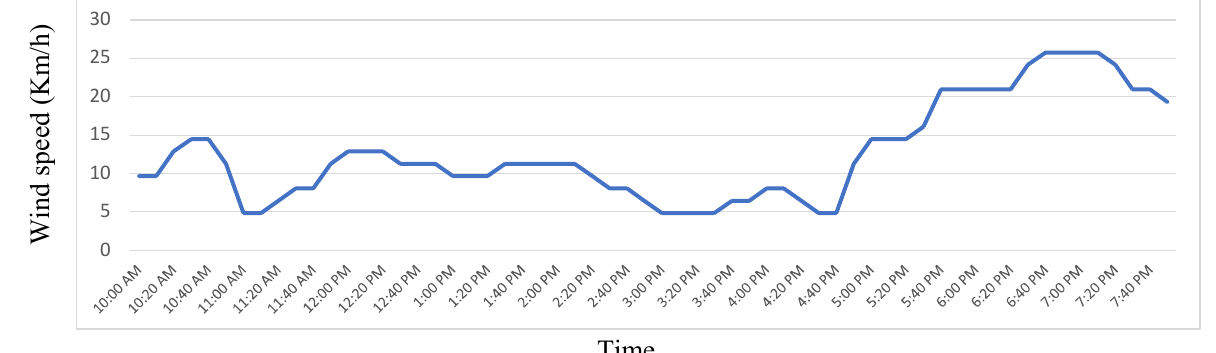
Figure 15. Wind speed records of the agro-weather